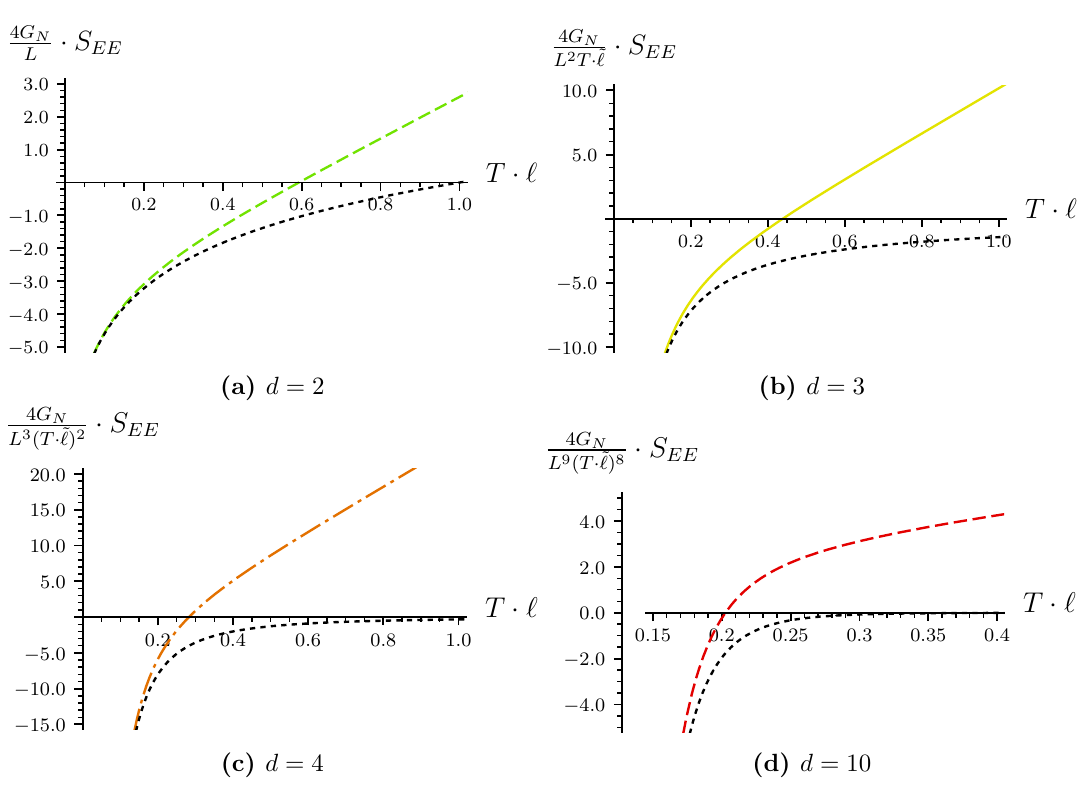
Figure 9. Entanglement entropy for di(cid:11)erent dimensions. We subtracted the cut-o(cid:11) term, which is proportional to ln( (cid:15)=z h ) for d = 2. The dotted black line is the zero-temperature